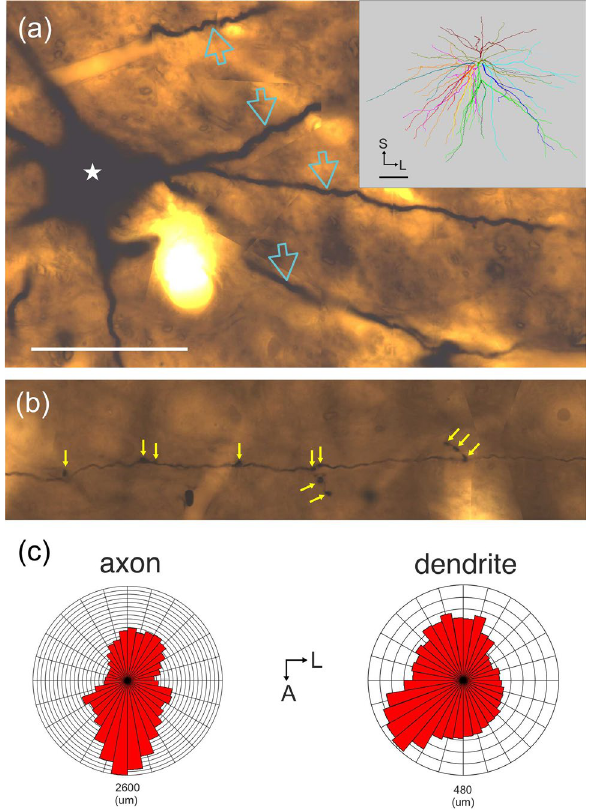
Figure 2. ( a ) High-power LM picture of the soma (star) and the dendrites (arrows) of L6SC. Note that the large cell body (diameter: 29.7 µm) emits thick, spine-free dendrites. Inset shows the 3D-reconstruction of the dendritic field where each dendrite including the daughter branches has different colors, respectively. It is notable that for most of the dendrites the branch points are located proximal to the soma origin followed by a long tapering course radiating out in all directions (drawing was created using the software package Neurolucida (v.8.26, MBF Bioscience, https:// www. mbfbi oscie nce. com). ( b ) LM montage of boutons (arrows) along the axon of L6SC. Both en passant and bouton terminaux are marked by arrows. ( c ) Polar histograms show the axonal (left) and dendritic (right) fields in the horizontal plane. A anterior, L lateral, S superior. Scale bars ( a , b ): 50 µm, inset: 0.5 mm.